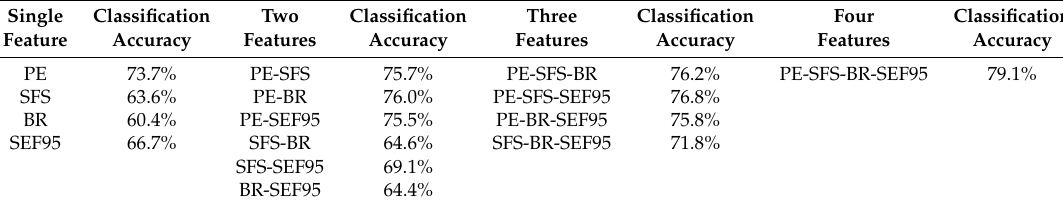
Table 3. The results of all combinations of 1, 2, 3, 4 features with ANN.